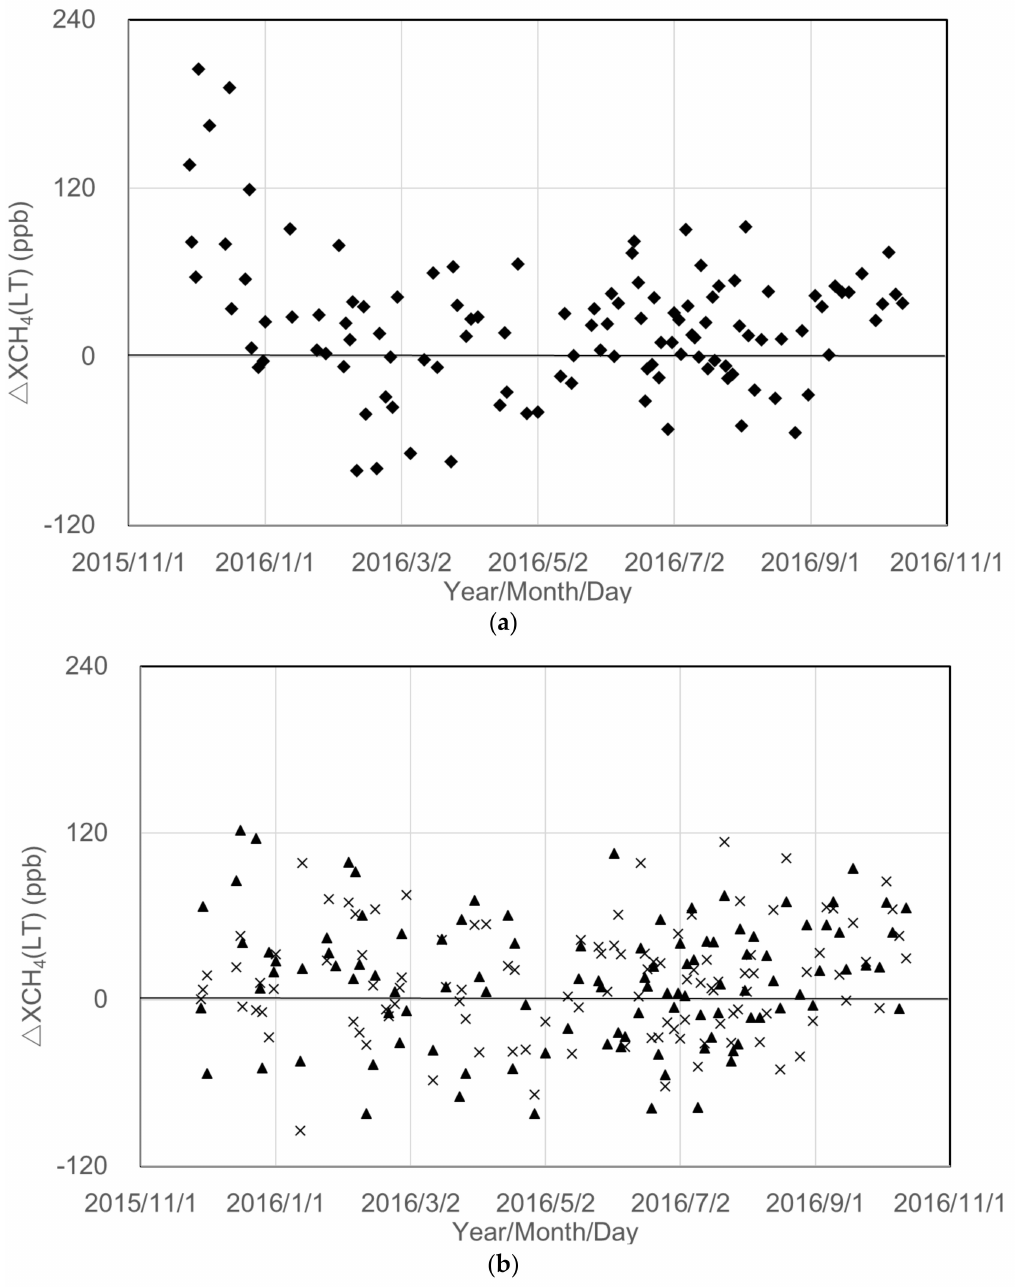
Figure A1. Time trend of successfully retrieved data: ( a ) XCH 4 (LT) enhancement from Simi Valley data of Aliso Canyon-S (diamonds); and ( b ) the same as ( a ) except for Aliso Canyon-N (triangles) and Burbank